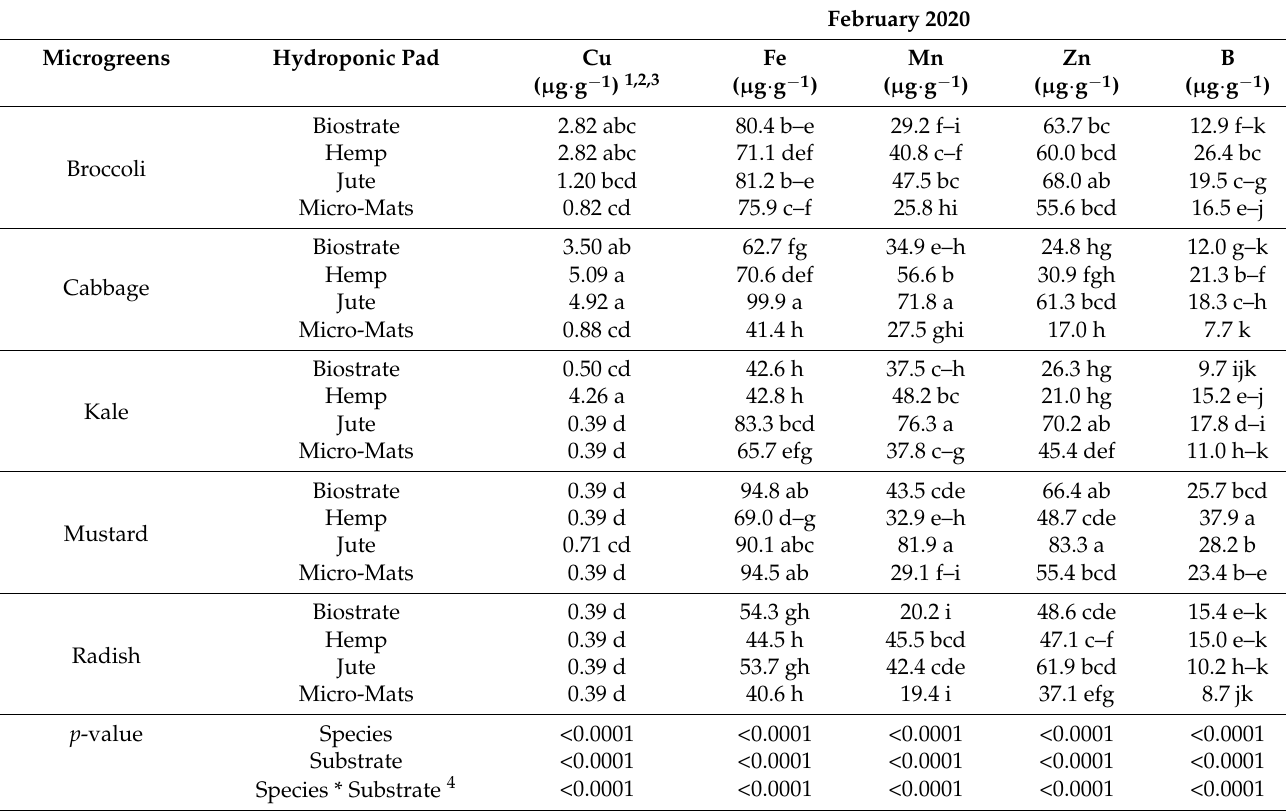
Table 10. Micronutrient concentrations in five microgreens affected by the interaction between species and hydroponic